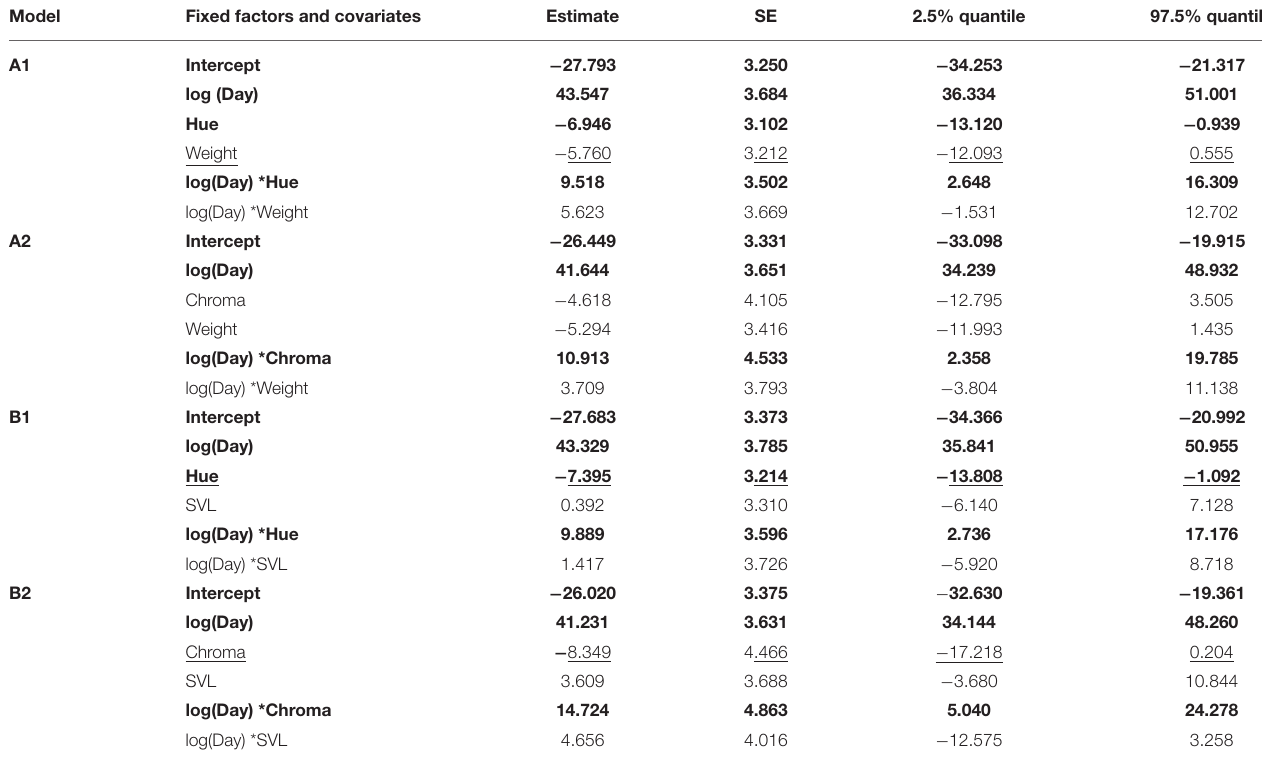
The presented quantiles limit the 95% credible interval. Significant effects are shown in bold and trends are underlined. N = 39.